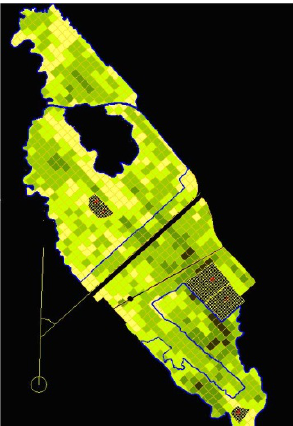
Figure 8. Detail of a thematic map showing the coarse data granularity 7 Data classification and learning of the fire susceptibility map